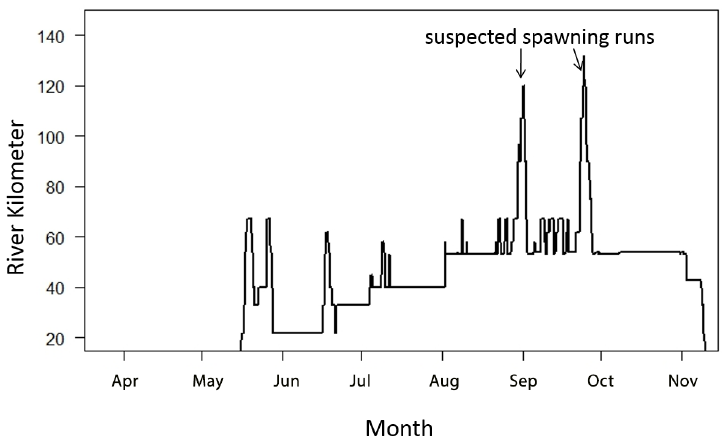
Fig 3. The 2013 telemetry movements of a female caught on 20 April 2011 at rkm 35. When captured her ova were immature and averaged 1.7 mm in diameter. The fish staged downstream in brackish water except for two suspected spawning runs in the in September. This female would have been susceptible to harvest as early as May when the historical fisheries were targeting what was thought as spring-spawn fish. Fall- spawning fish were likely harvested throughout the late spring and early summer which may be why the fall season was never officially documented in